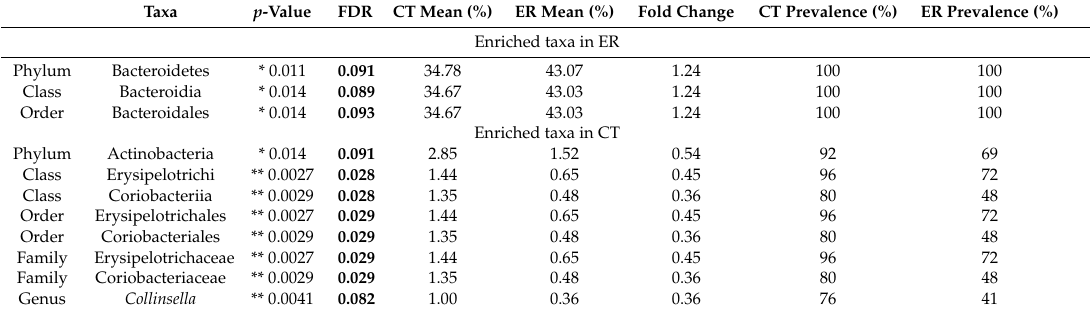
Table 2. Differentially enriched taxa in early rheumatoid patients and healthy controls showing the top 20 taxa at each level.